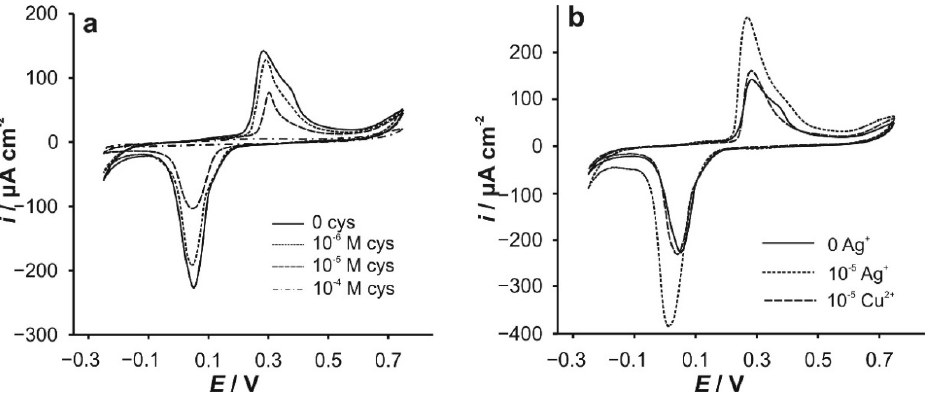
Figure 4. ( a ) Cyclic voltammograms recorded with CPE, modified with 5% of the material, without and in the presence of: ( a ) cysteine (successive addition of cysteine); ( b ) 10 − 5 M of silver ions or cupric ions. All presented CVs were recorded in acetate buffer solution at pH 5, at a scan rate of 50 mV s − 1 . As shown, both current peaks decreased as the cysteine concentration increased. A decrease of both of the peaks was followed by no shift in the potentials of the current peaks. This indicates that the phenomenon arose from the lower concentration of silver ions. This lower concentration was a consequence of the complexation of the cysteine with silver ions; it is well known that thiols tend to react with silver ions to form stable, undis- sociated, mercaptides [18,41]. A decrease of both current peaks took place at cysteine concentration ranges between 0.1 and 10 μ M. At higher concentrations of cysteine, the electrode become polarizable in